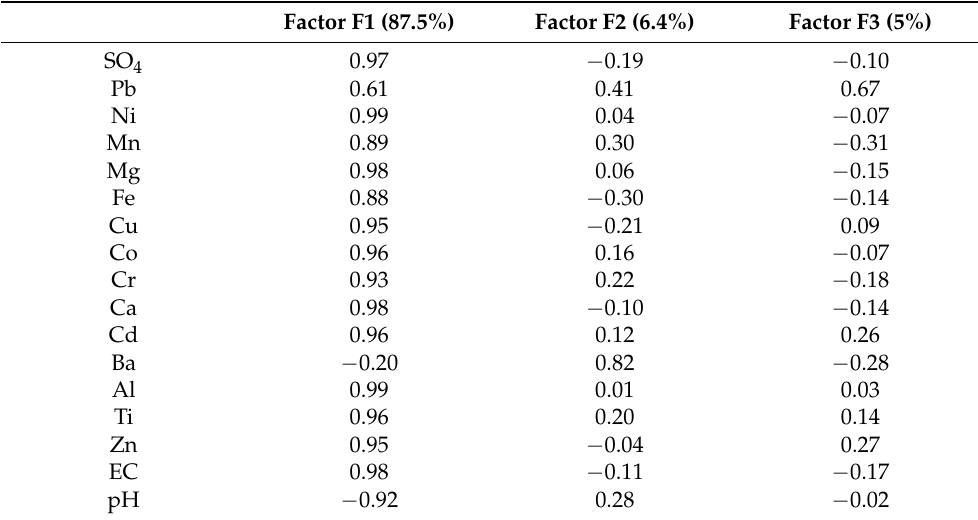
Table 3. Correlation between chemical parameters from observation wells installed in 2011 (first campaign).